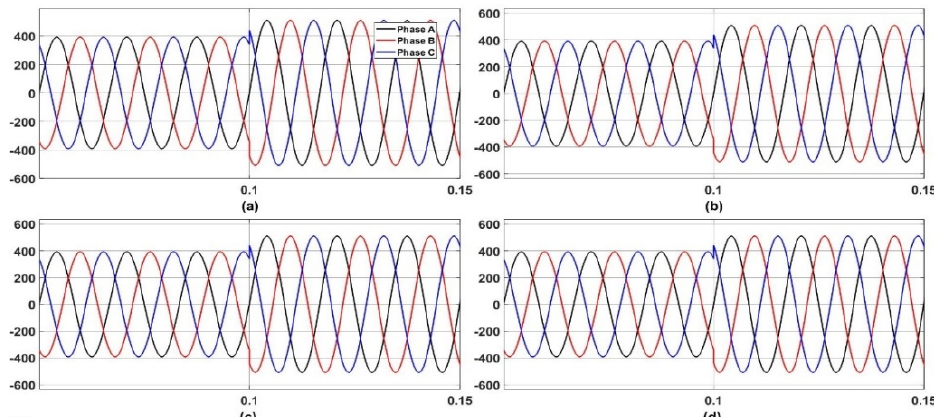
Figure 19. Three-phase voltages in a balanced swell in the case of ( a ) 2L- αβ , ( b ) 3L- αβ , ( c ) 2L-dq and ( d ) 3L-dq.